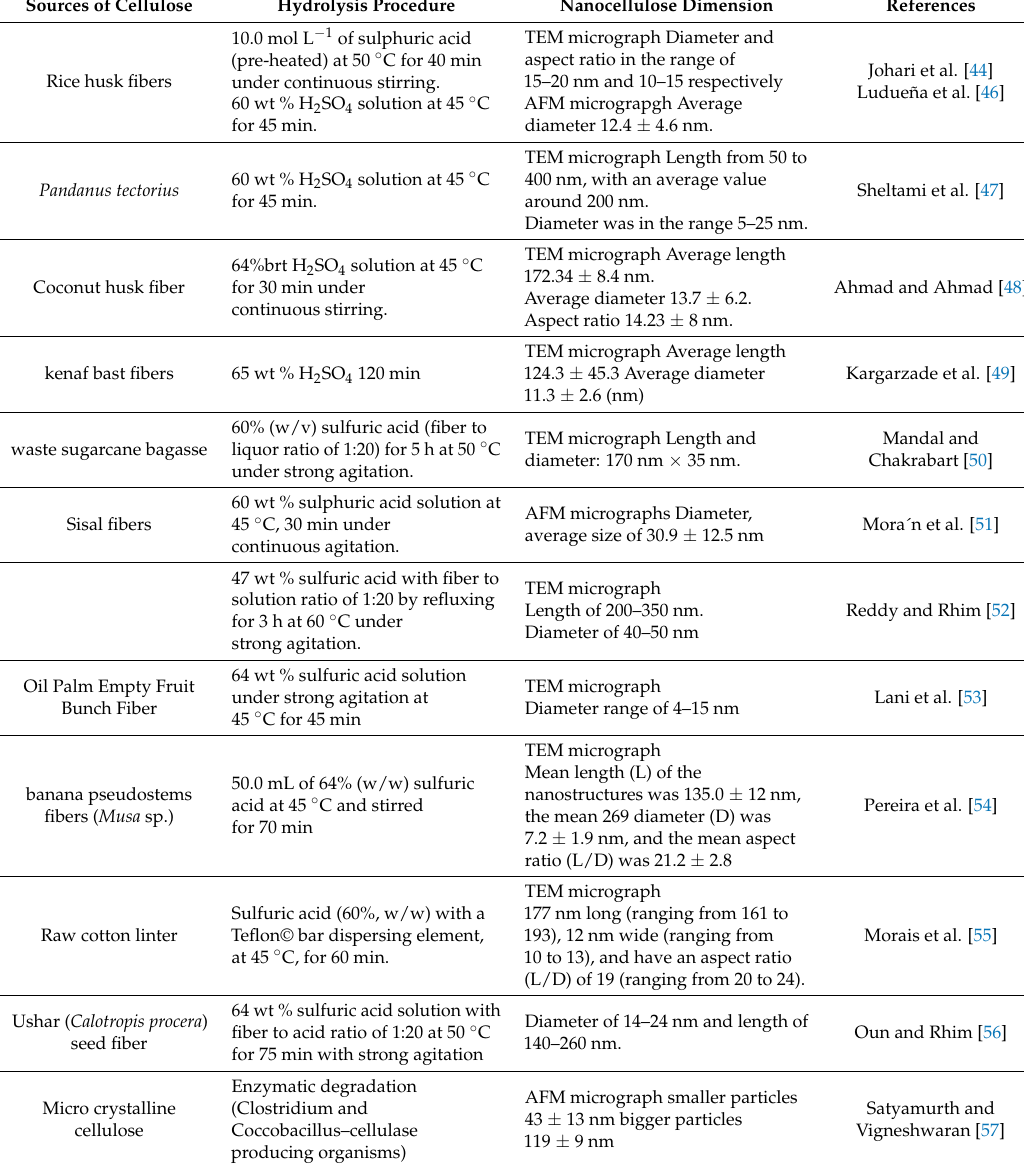
Table 1. Typical geometrical characteristics for cellulose nanocrystal (CNC) originating from different cellulose sources and obtained via different